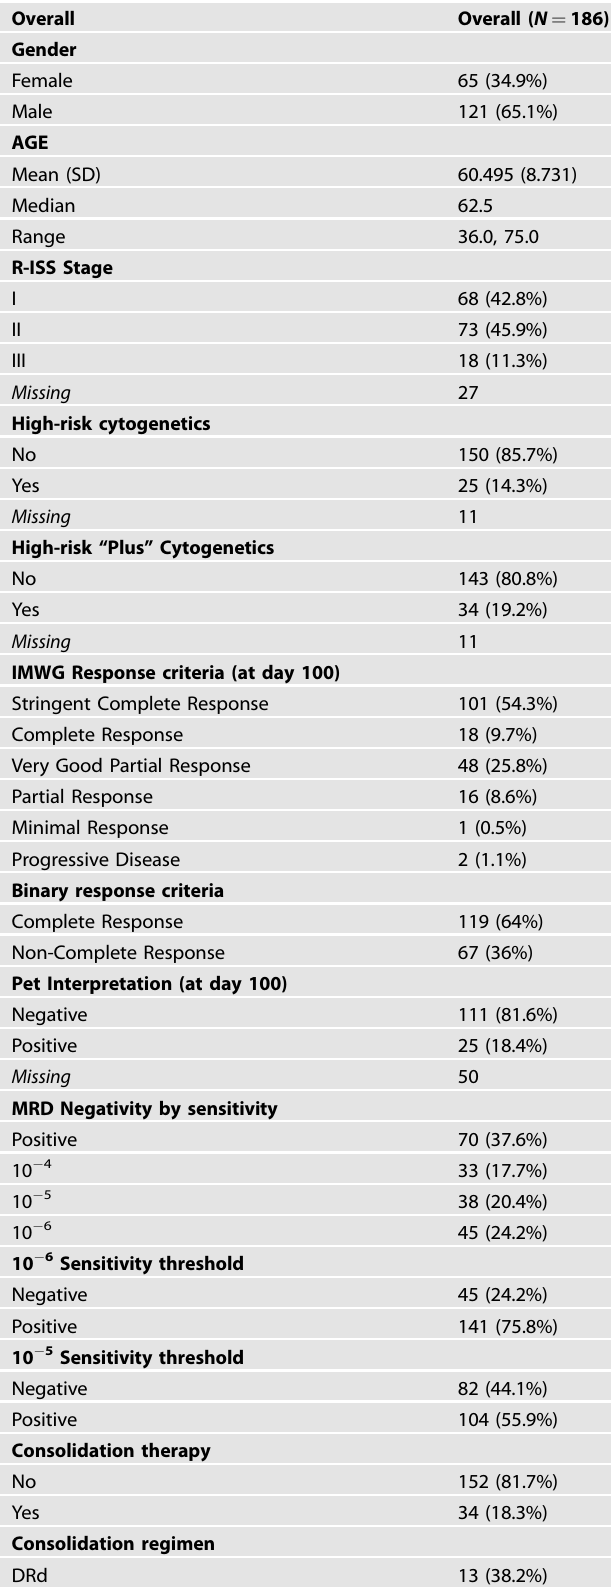
Table 1. Patient demographic characteristics and response status at day 100 Post-Autologous Stem Cell Transplant